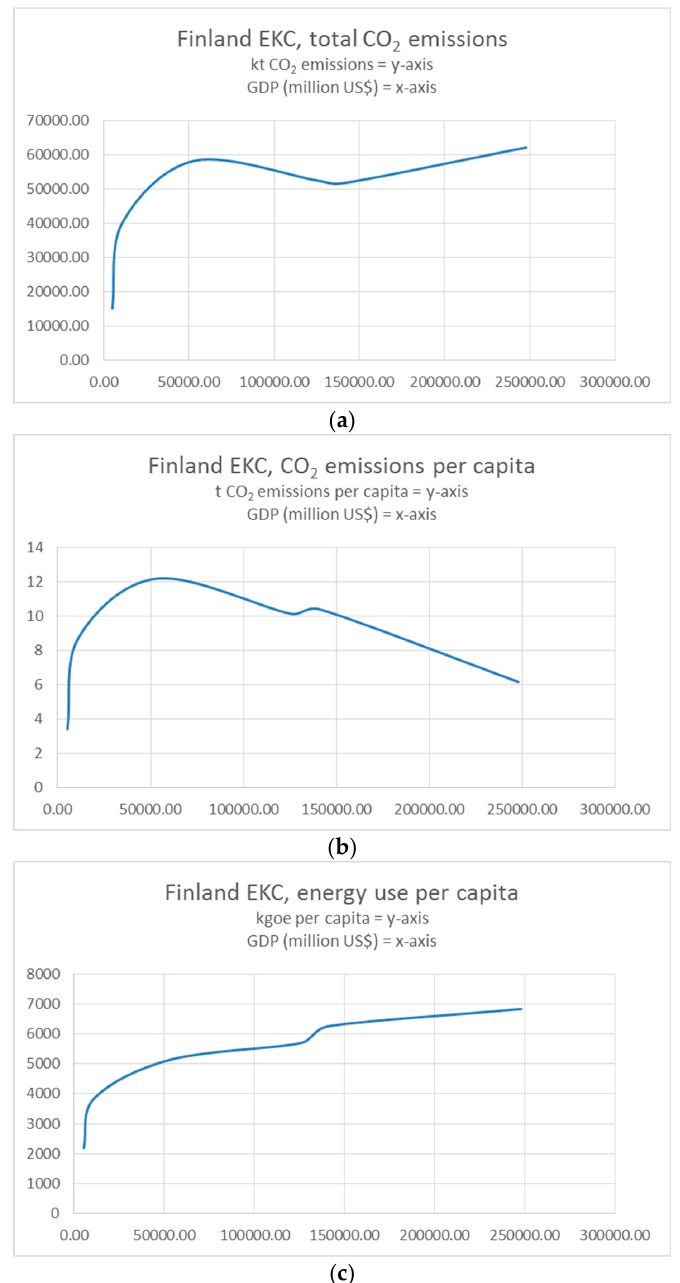
Figure 6. Analysis of the EKC for Finland. Data source: [44]. ( a ) Finland EKC, total CO 2 emissions; ( b ) Finland EKC, CO 2 emissions per capita; ( c ) Finland EKC, energy use per capita.